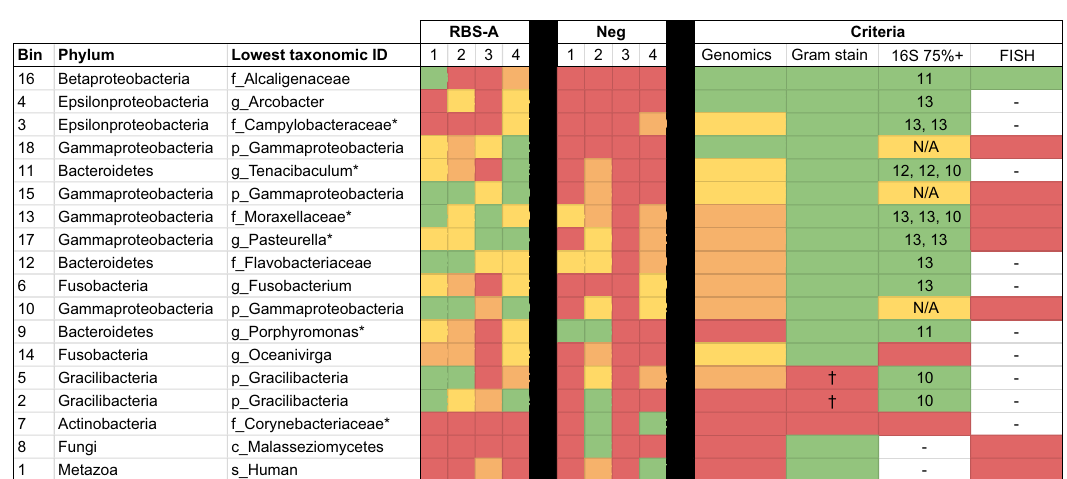
once ≥ 5%)?(Gramstain)Are membersof thistaxonomic group knowntobeGram- negative, like the RBSs? (16S 75%+) Of ASVs detected in >75% of samples that underwent 16S rRNA gene amplicon sequencing and were visually con fi rmed to contain >10 RBS-As ( n =13), was an ASV of this taxonomic identity? Numbers in boxesindicatethenumberofsamplesinwhichthisASVwaspresent.Forrecovered bins detected only to the level of class Gammaproteobacteria, a large and diverse group, this criterion is marked in yellow and ASV counts are not shown. (FISH) Based on FISH results, which bins are supported as potential candidates for the RBS-As? A cross ( † ) denotes that members of the phylum Gracilibacteria are inferred not to be Gram-negative from genomic studies (although they are not necessarily Gram-positive) 92 . The highest likelihood candidates are green for all three criteria.